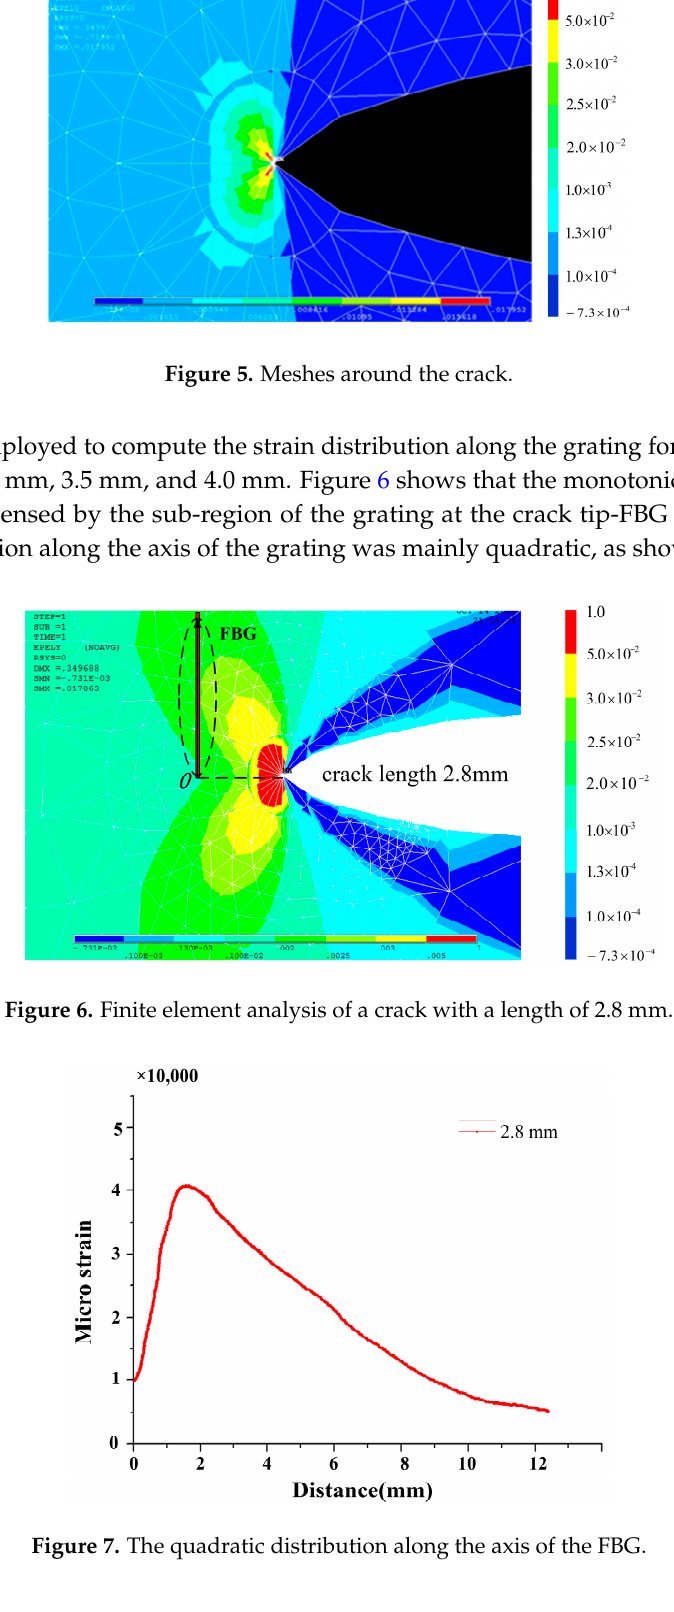
Figure 7. The quadratic distribution along the axis of the FBG.